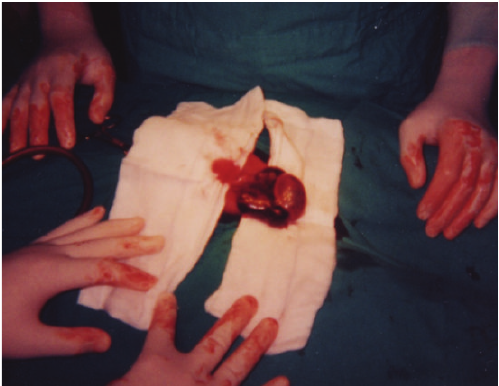
Figure 1: Patient’s preparation.